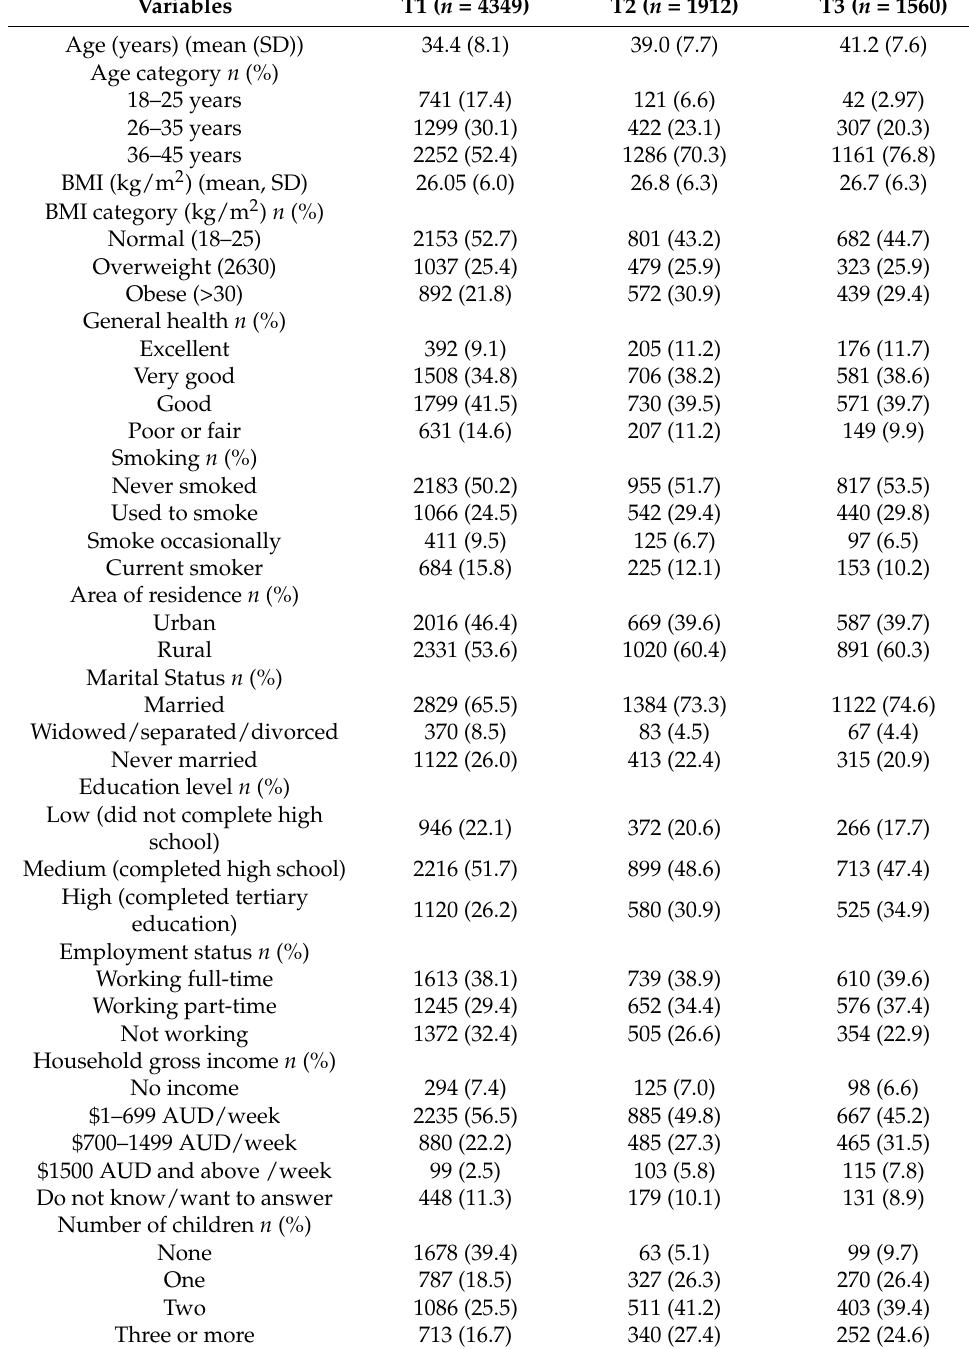
Table 1. Sociodemographic and health characteristics of participants in the READI